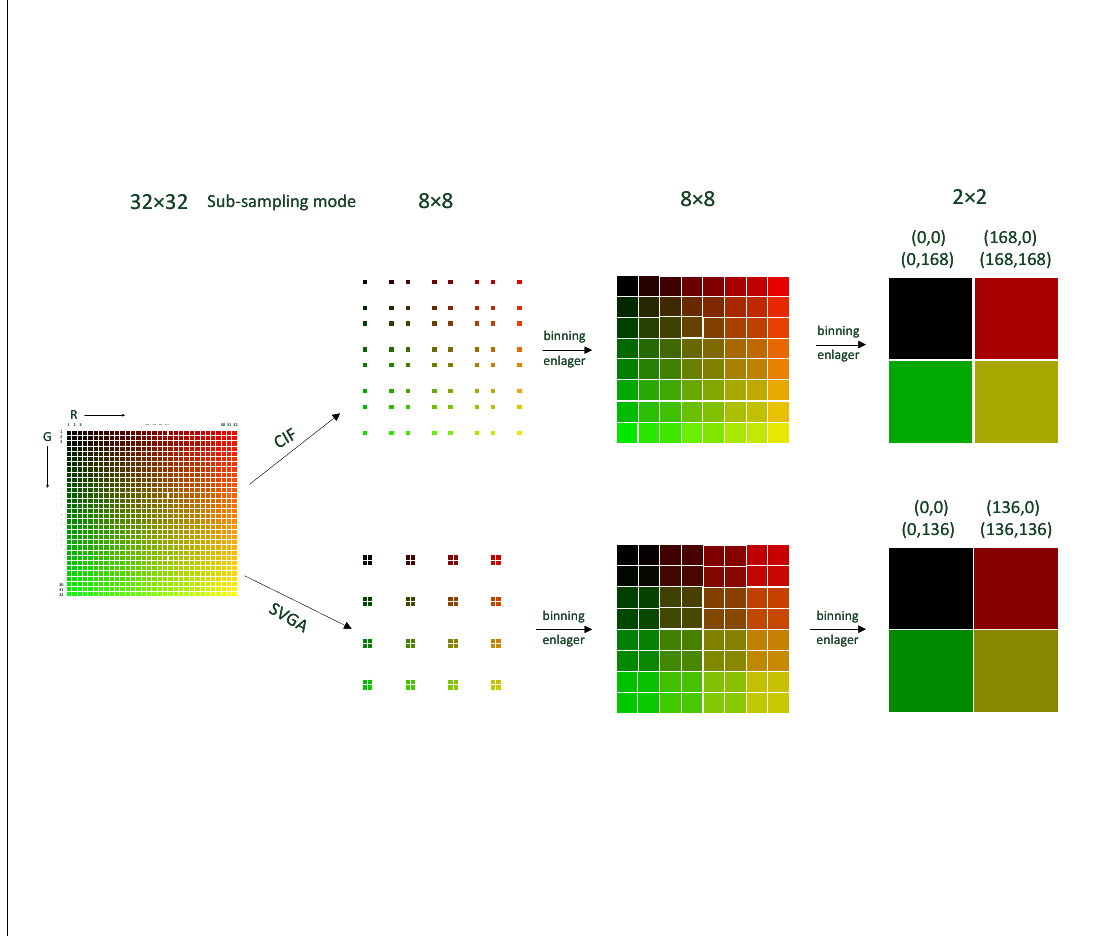
Figure 6. Color distortion of 4:4 skipping and 2:2 skipping.